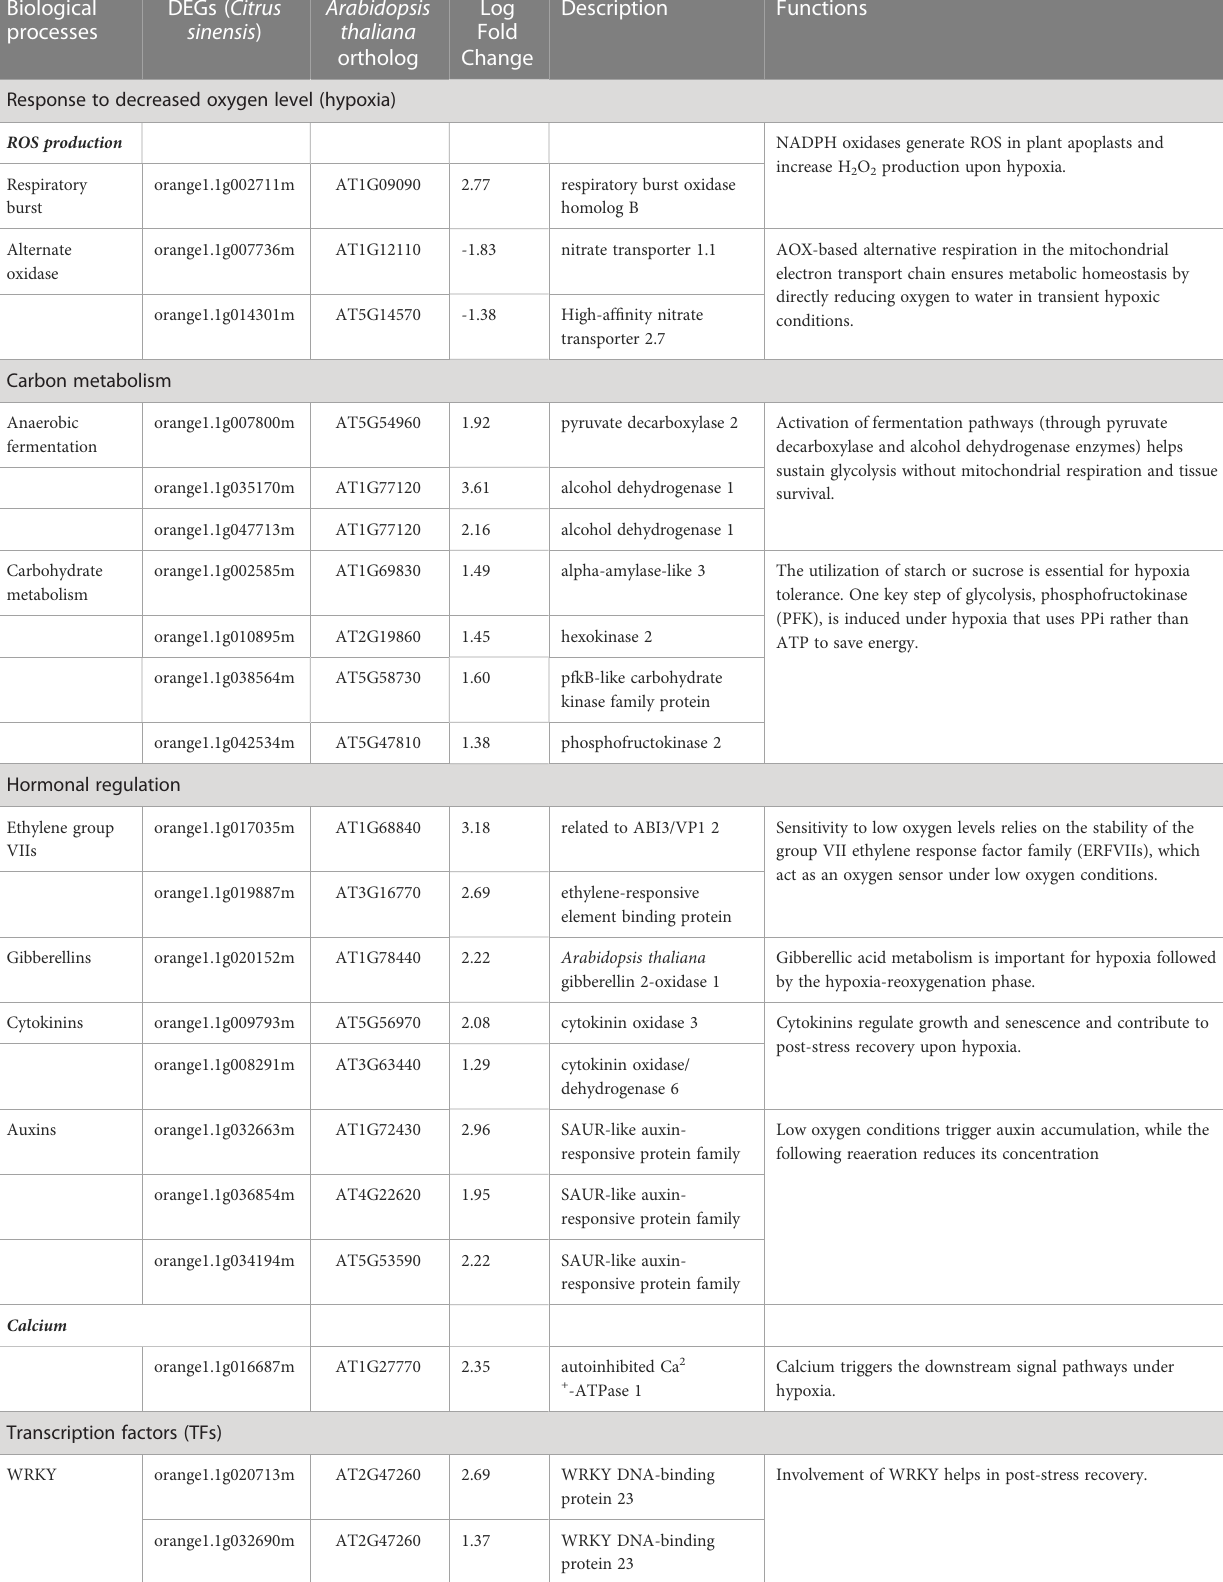
TABLE 3 Differentially expressed genes (DEGs) relating to biological processes induced by cellular hypoxia levels and during the hypoxia- reoxygenation phase in buds of severely symptomatic Huanglongbing (HLB)-affected ‘ Hamlin ’ sweet orange trees compared to mildly symptomatic trees in